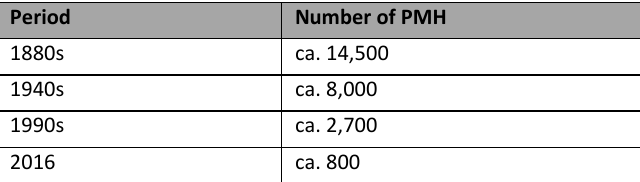
Table 1: A decreasing trend in the number of PMH Source: Compiled by the